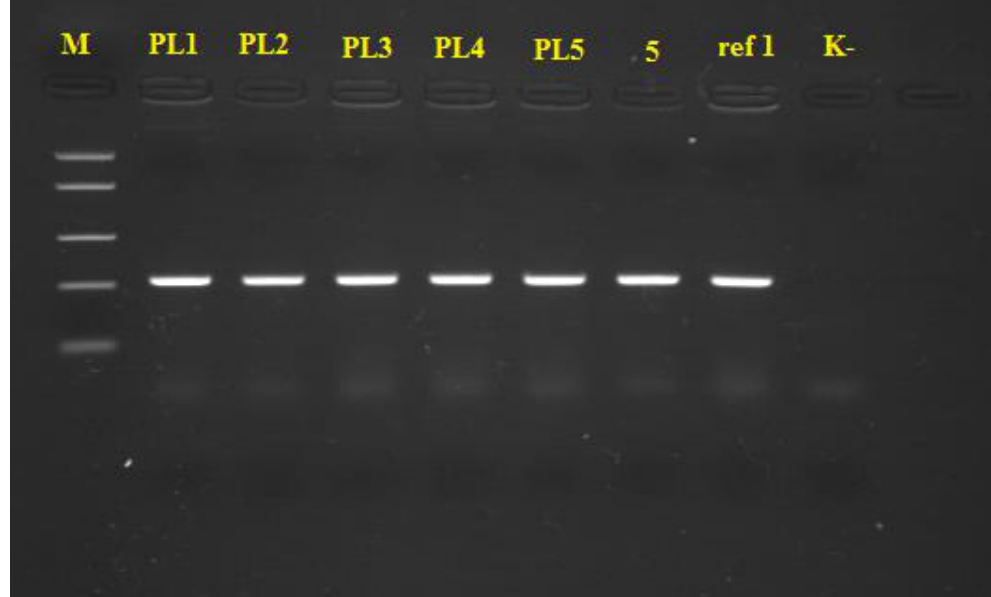
Figure 2. Visualization of the amplified PCR products in 1.5% agarose gel during PCR identification of pathogenic Xanthomonas spp. (M—gene ruler, PL1-PL5—PCR products from phytopathogenic Xanthomonas spp., 5 and ref 1—PCR products from referent isolates, K—negative control)